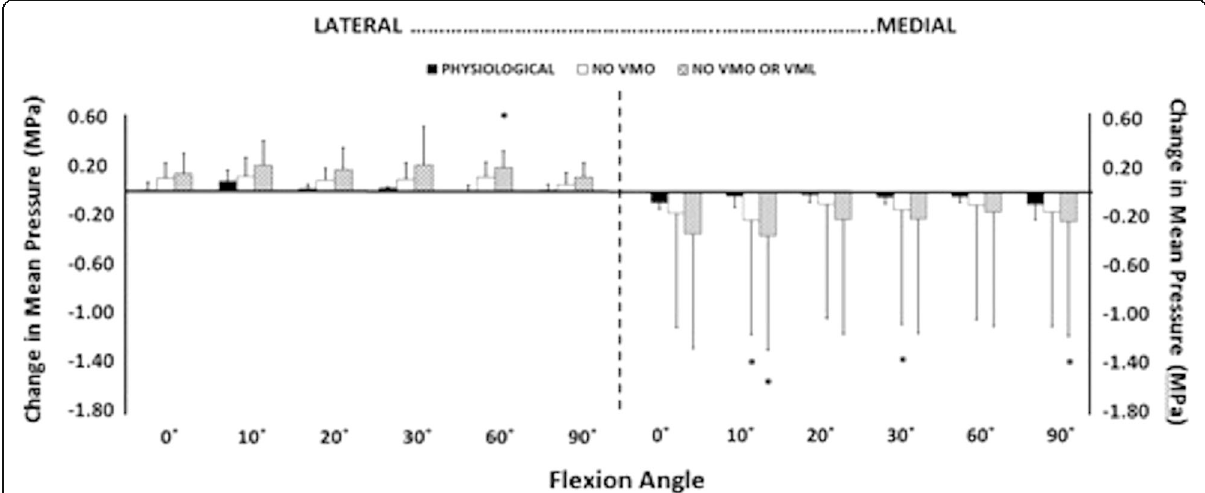
Fig. 9 Change of mean patellofemoral contact pressure, across knee flexion, caused by imposing a 10 N lateral displacing force to the patella